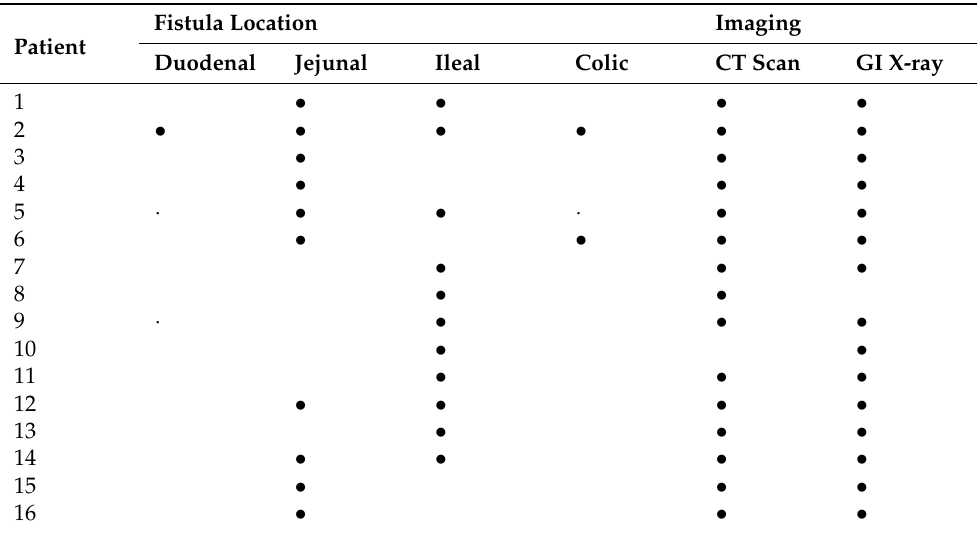
Table 2. Investigation phase. Fistula location for each patient and type of radiological study are